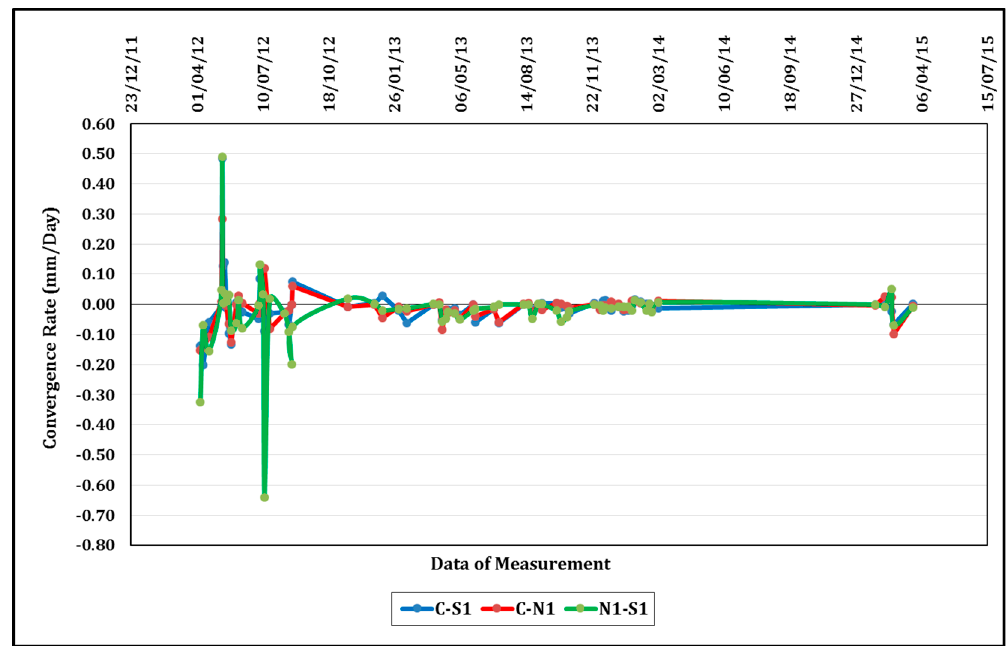
Figure 8. Convergence rate at the chainage 1 + 787 of KUR in relation to time.